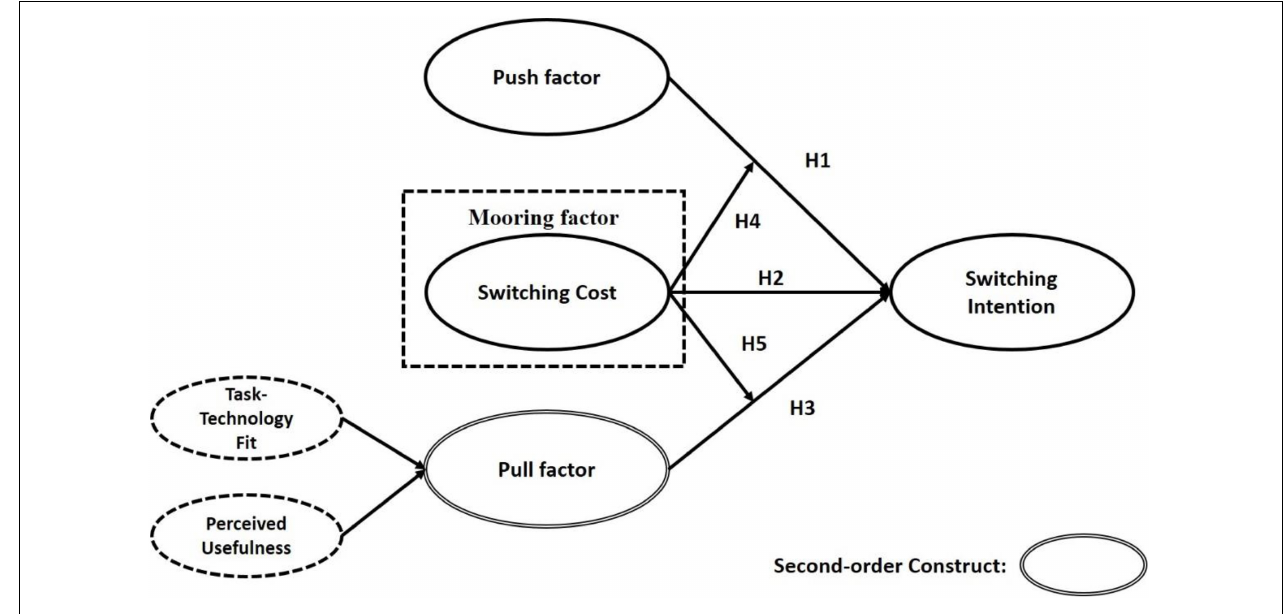
FIGURE 1 | Research